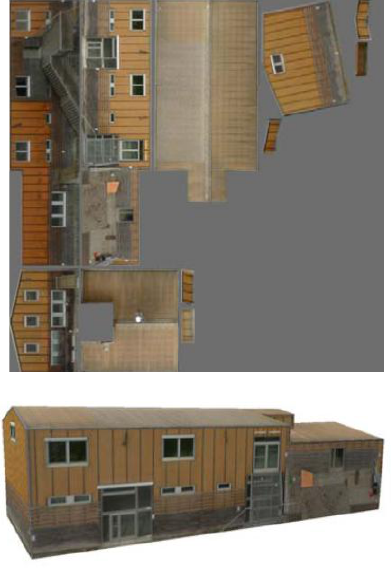
Figure 12 . Texture components and the 3D-Model derived from UAV images of the HXE-building at Campus Science City Campus ETH Hoenggerberg, displayed in VRMLVIEW The final textured model can be exported as VRML (Virtual Reality Modeling Language) for general 3D viewers or as a KMZ file for display in Google Earth, see Figure 13.